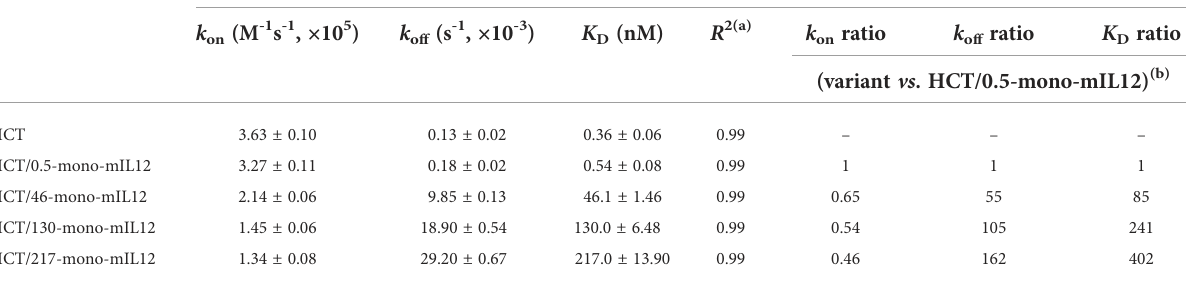
TABLE 1 Binding kinetics of interactions between soluble HER2 and immobilized HCT-mono-mIL12, as measured by bio-layer interferometry. Binding kinetic parameters